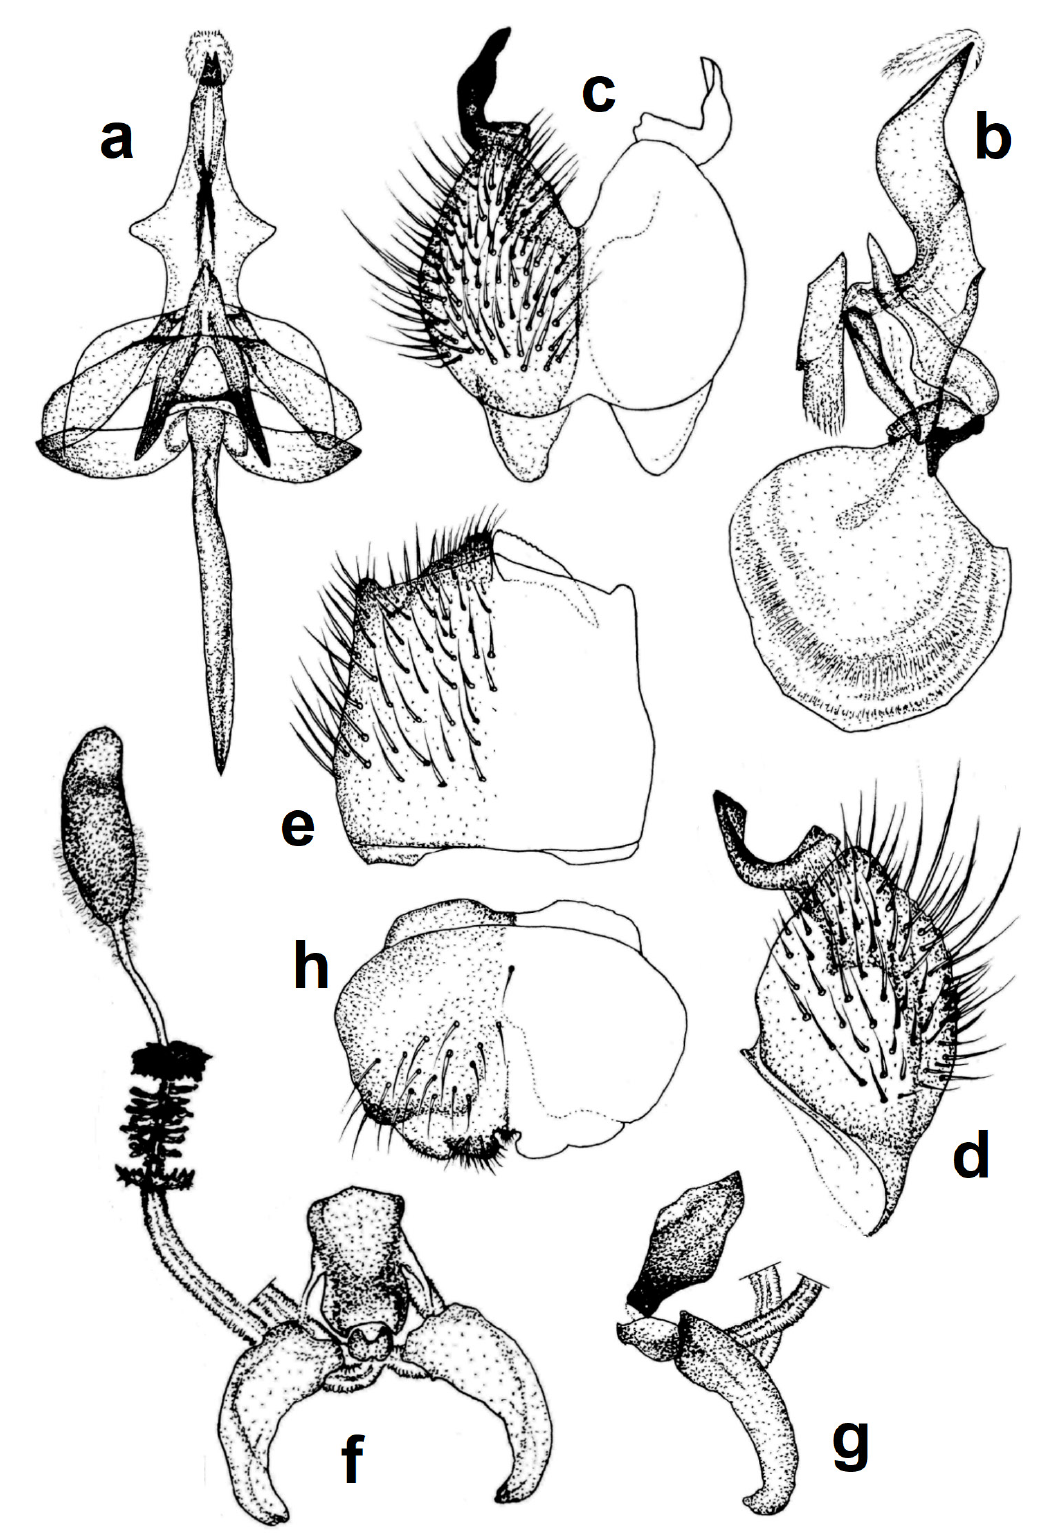
Fig. 64. Parusia faesae gen. et sp. nov. a . Epiphallic complex ventral. b . Epiphallic complex lateral. c . Gonocoxite ventral. d . Gonocoxite lateral. e . Epandrium dorsal. f . Female genitalia ventral. g . Female genitalia